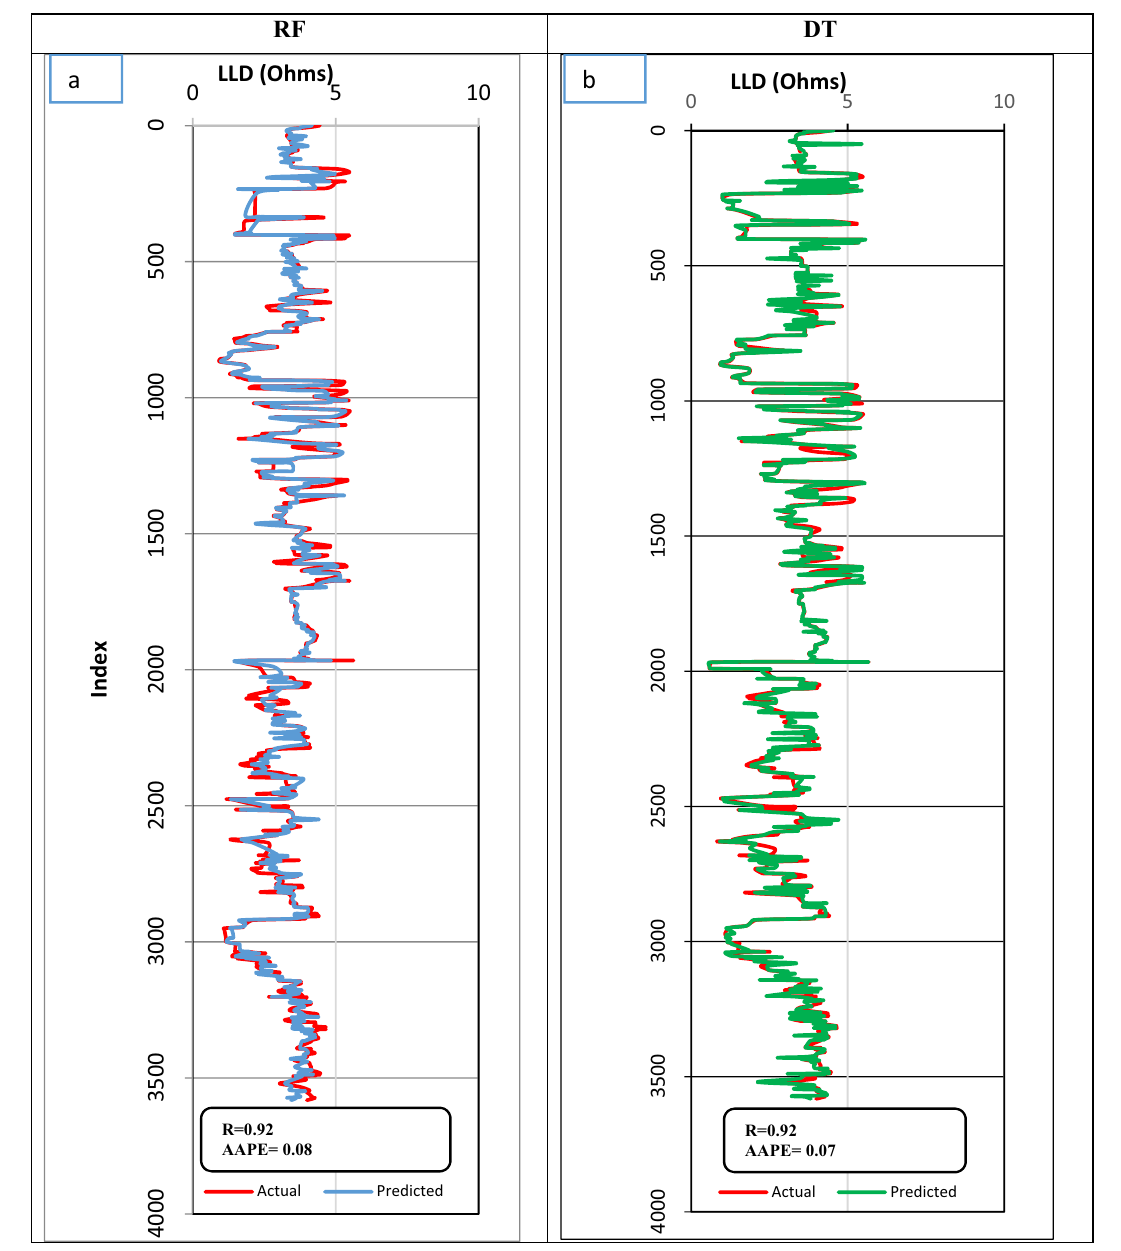
Fig. 3 Actual versus predicted oil well resistivity for the testing stage from a RF and b